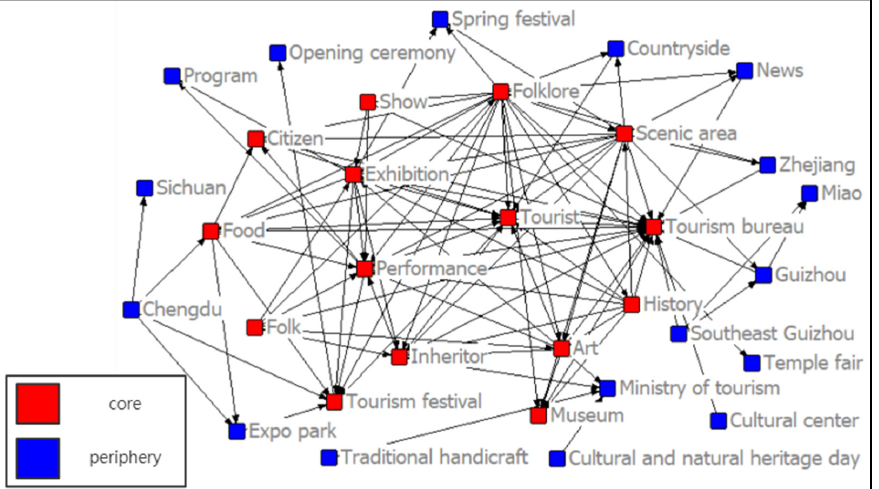
Figure 5. Semantic network of ICH tourism cognition after hierarchical merging. Finally, the authors placed these semantic network nodes into a core/periphery framework and compared the dimensions (Table 4). Among the 32 network nodes, 15 ap- peared in the core part of the semantic network, involving three dimensions (ICH and